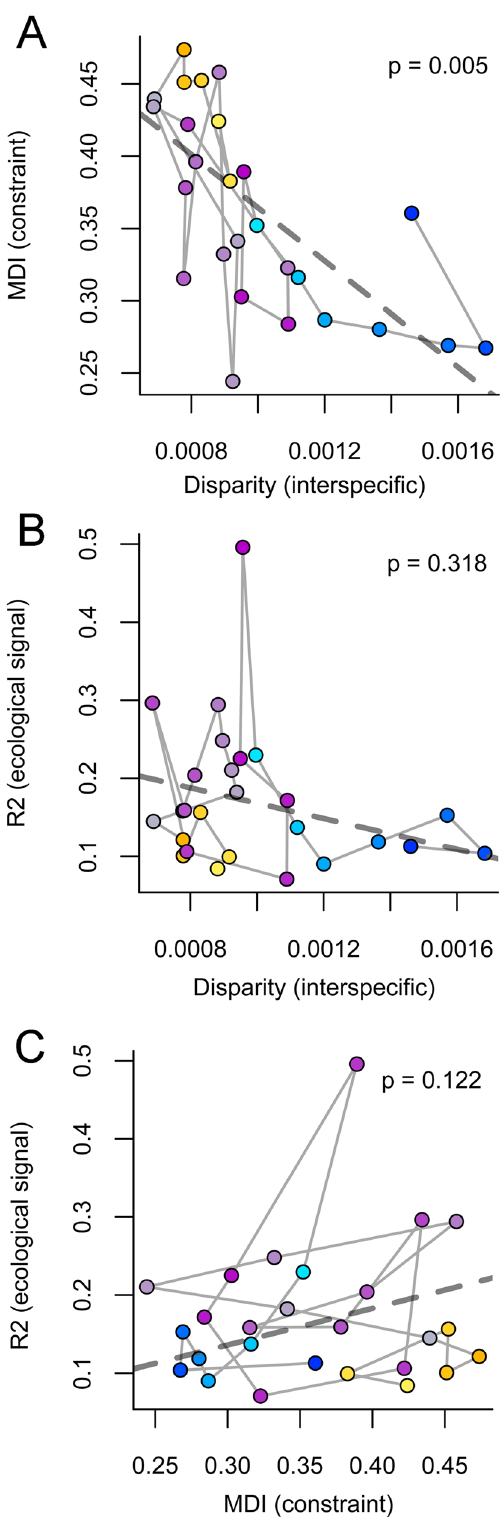
Fig. 7 Relationships between ecomorphological adaptation, evolutionary constraint (MDI) and among-species disparity grouping vertebrae by number. A Bivariate plot of MDI values against among-species disparity. B Bivariate plot between the strength of ecomorphological signal ( R 2 from the best Procrustes ANOVA analyses) and interspeci fi c disparity. C Bivariate plot between the strength of ecomorphological signal ( R 2 from the best Procrustes ANOVA analyses) and evolutionary constraint